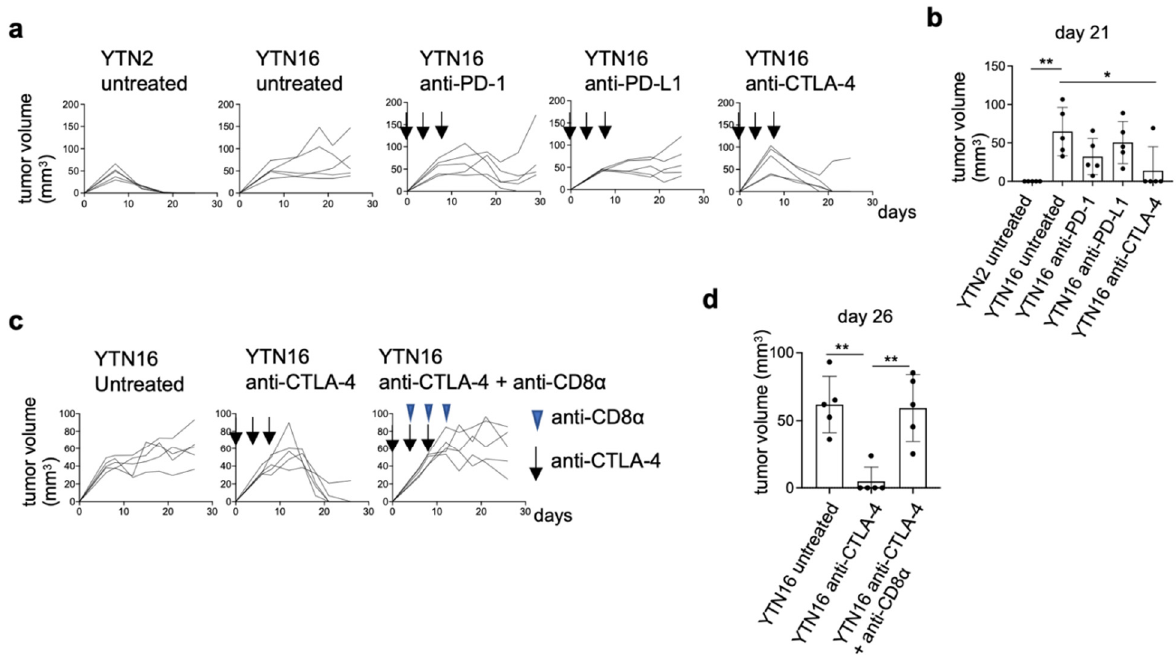
Figure 1. Immunological characterization of YTN2 and YTN16 in terms of tumor growth and sensitivity to checkpoint inhibitors: ( a ) Mice ( n = 5) were inoculated with 5 × 10 6 YTN2 or YTN16 cells on day 0. Anti-PD-1 (clone RMP1-14, 200 µ g/mouse), anti-PD-L1 (clone 10F9G2, 200 µ g/mouse) or anti-CTLA-4 (clone 9H10, 100 µ g/mouse) mAbs were administered on days 0, 4, and 8. Tumor volumes were monitored every 2 or 3 days. Arrows indicate the days of antibody injection. ( b ) Tumor volumes on day 21 were shown. * p < 0.05, ** p < 0.01, one-way ANOVA with Dunnett’s test for multiple comparisons. ( c ) Mice ( n = 5) were inoculated with 5 × 10 6 YTN16 cells on day 0. Anti- CTLA-4 and anti-CD8 α (clone 53-6.7, 200 µ g/mouse) mAbs were injected on days 0, 4 and 8, and 4, 8, and 12, respectively. Tumor volumes were monitored every 2 or 3 days. Arrows and arrowheads indicate the days of anti-CTLA-4 and anti-CD8 α injection, respectively. ( d ) Tumor volumes on day